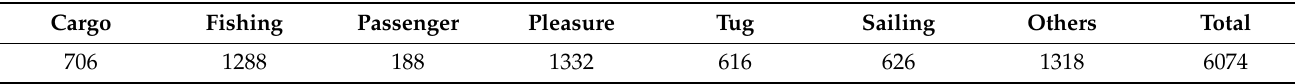
Table 1. Number of shipping noise measurements for each type of ship.